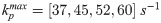
Final steady state configuration of the membrane is reached faster in the case of non-progressive gel for different values of polymerization rate.The dynamics of membrane’s middle point versus time for different values of kpmax=[37,45,52,60]s-1, with the force Fe = 16 pN applied to the edges. (a) Non-progressive gel versus (b) progressive gel boundary with vgmax=20nm/s.